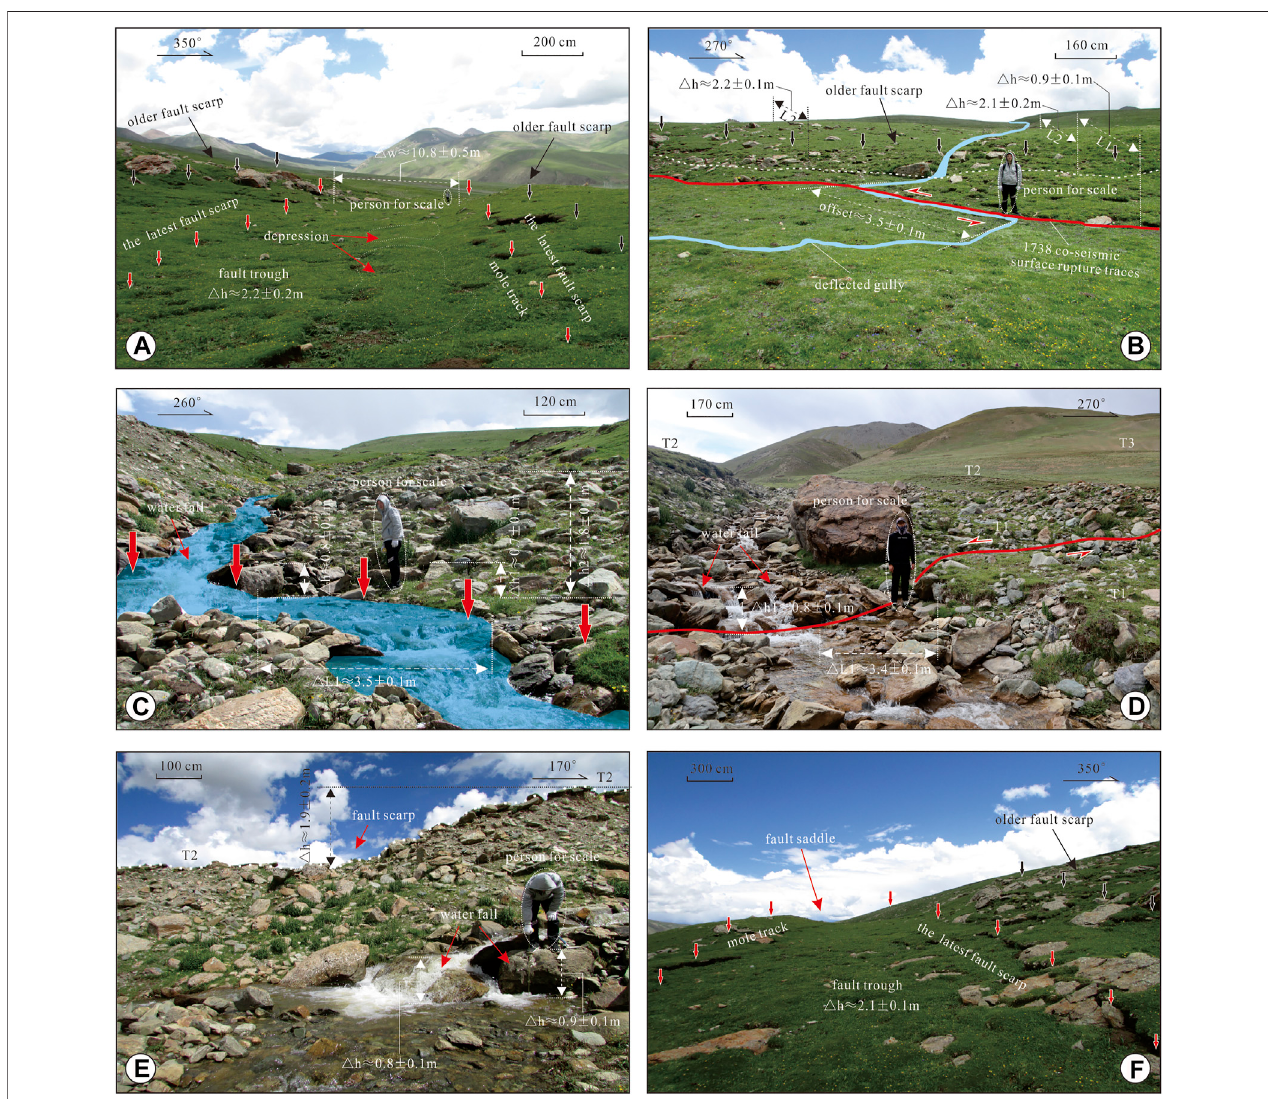
FIGURE 6 | Photographs of representative tectonic landforms of the DJF and CE 1738 co-seismic surface ruptures in the middle section of the structure. Arrows represent the distribution of tectonic characteristics such as fault scarps, mole tracks, and depressions, while the red arrows delineate the latest tectonic deformation. The azimuth angles in the photographs represent the section direction. Note the difference in each scale of the picture. Pictures from, to correspond to the locations of thephotographsin Figure3 M. (A) An~2.2±0.2 m-highco-seismicsurfacescarpinapreexistinggrabenwithabreadthof~10.8±0.5 malongthefaultvalley; (B) fault scarp and depressions developed within unconsolidated alluvial and pluvial deposits, which are duplicated in a preexisting structure zone. Note the youngest gully terrace was vertically dislocated by approximately 0.9 ± 0.1 m, which was horizontally de fl ected or offset by ~3.5 ± 0.1 m; (C) A modern stream was de fl ected ~3.5 ± 0.1 mandverticallyoffset~0.8±0.1 m(theheightofthewaterfalldropinthemapbasicallyrepresentstheverticaldisplacementofthelatestco-seismicsurfacerupture), while the higher geomorphologic surface that consists of boulders and gravels was vertically displaced ~1.8 ± 0.1 m on the preexisting structure zone; (D) A modern valley fl at was de fl ected ~3.4 ± 0.1 m and vertically offset ~0.8 ± 0.1 m (the height of the waterfall drop in the map basically stands for the vertical displacement of the latest co-seismic surface rupture), note the person in the map for scale; (E) A stream was vertically dislocated (the height of the waterfall drop in the map is measured